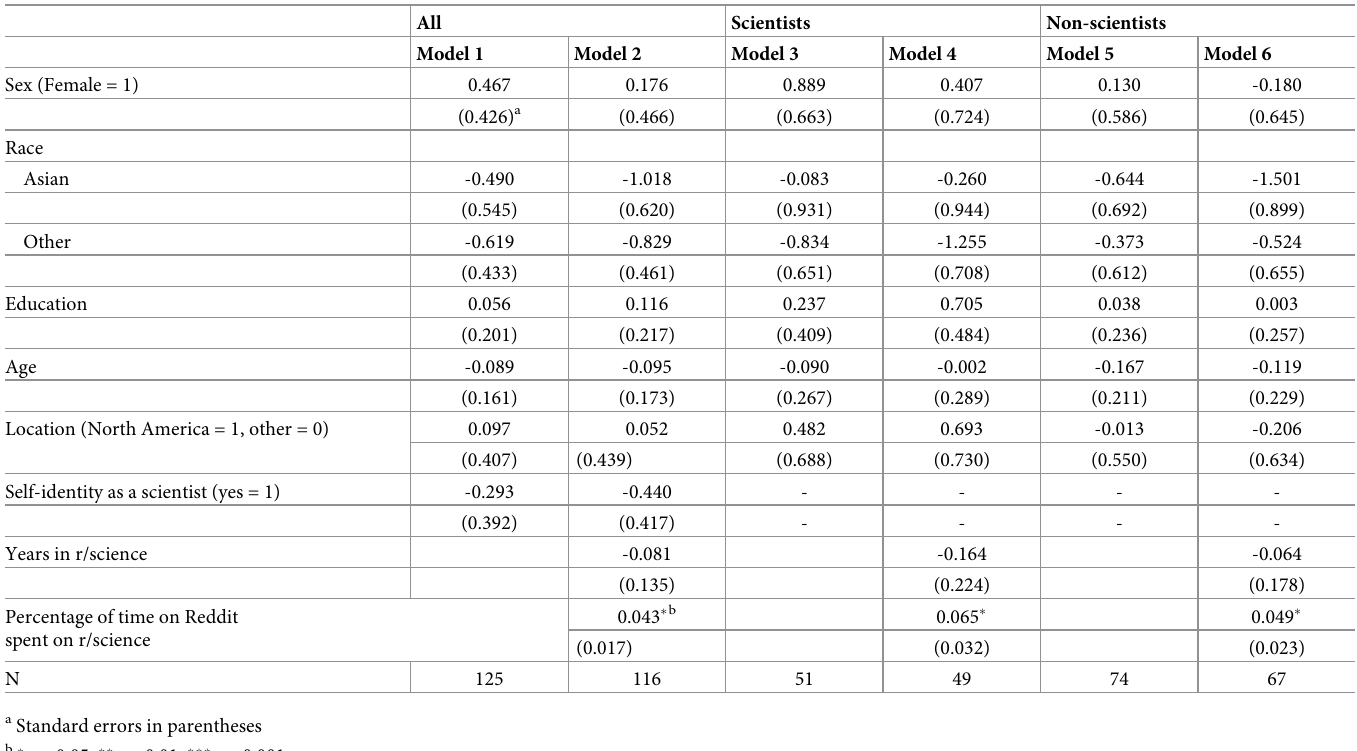
Table 7. Results of ordinal logistic regression of users’ demographics on the perceived effect of r/science exciting the public about science.